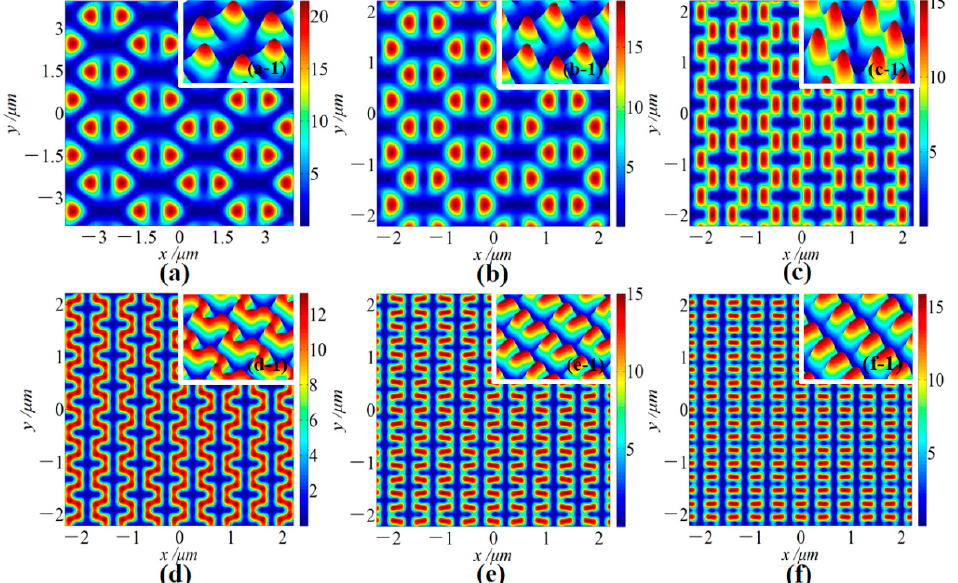
Figure 2. Optical field distribution of microstructures under six-beam LIL with the TE-TM-TM-TE-TM-TM polarization combination. The angles of incidence are ( a ) 15°, ( b ) 30°, ( c ) 45°, ( d ) 60°, ( e ) 75°, and ( f ) 85°. ( a-1 – f-1 ) are the three-dimensional light field diagram corresponding to ( a – f ).